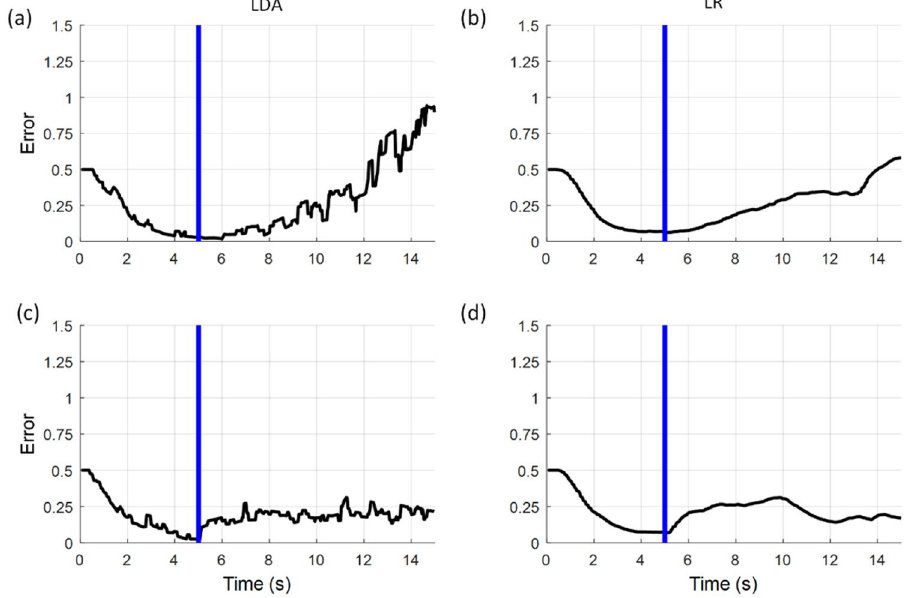
Figure 6. Results of closed-loop experiments for subject with transradial amputation. ( a , b ) Error in reaching when linearly increasing noise was added to the signals online for LDA ( a ) and LR ( b ). ( c , d ) Error in reaching when sudden noise was added to the signals online for LDA ( c ) and LR ( d ). All four scenarios show similar trends as the closed-loop experiments with able-bodied